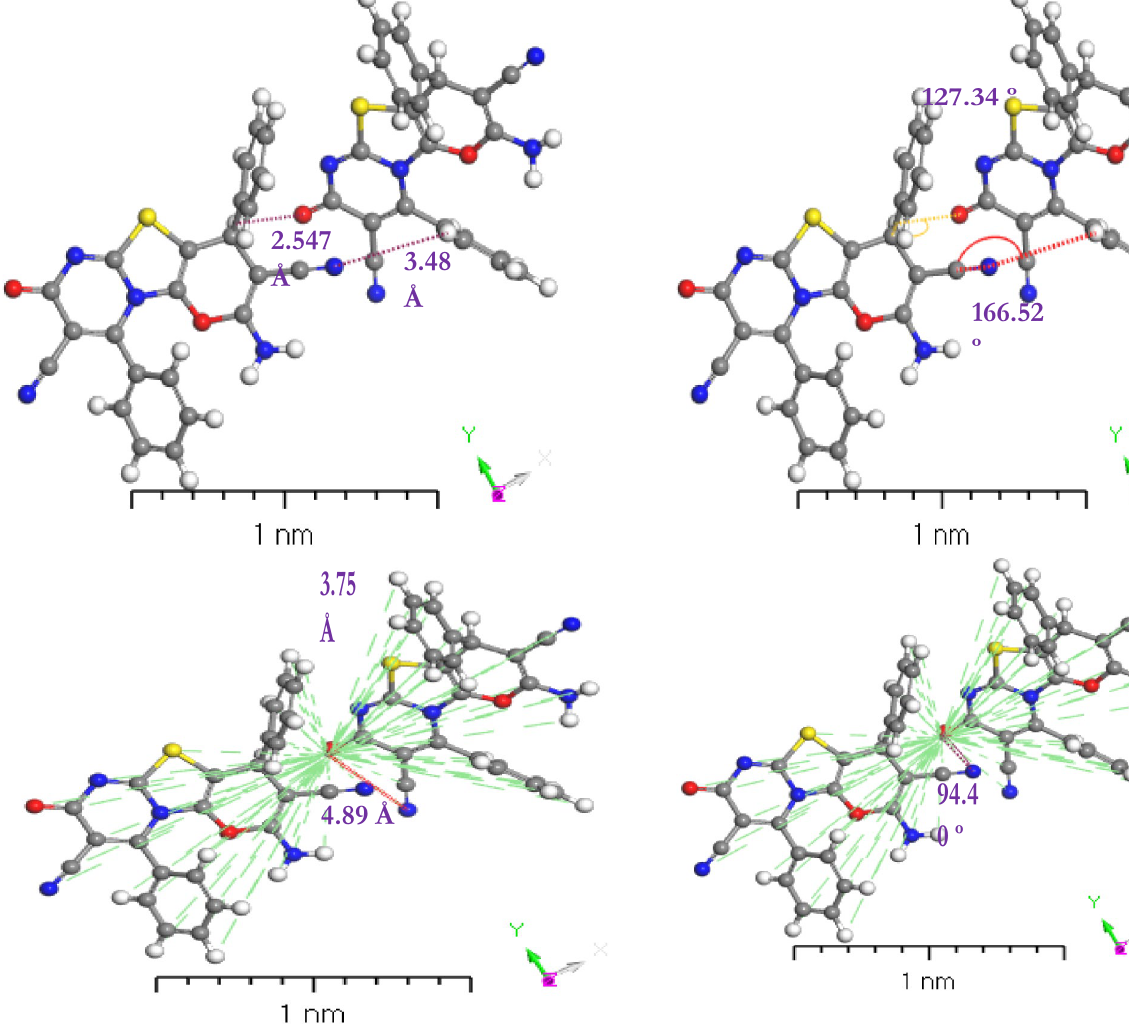
Figure 6. Stable structures of [ThiPy-3,8-Dc] dimers in the gas phase, calculated with